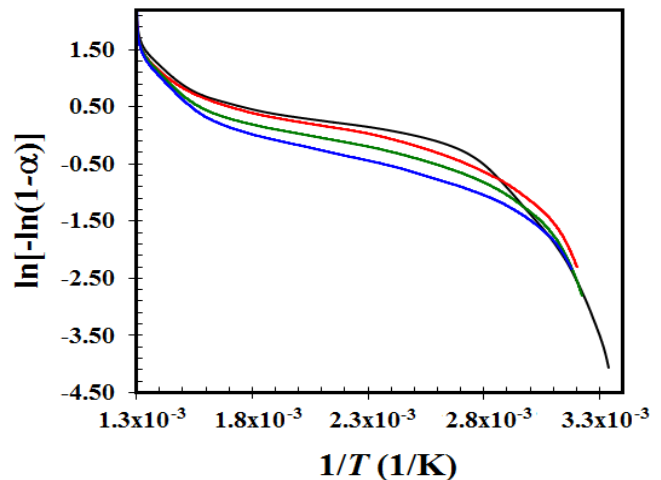
Figure 6. Experimental data for alumina ( — ), Fe/Al Pt-Fe/Al O 0.5%-0.5% ( — ) samples treated according Equation 2 3